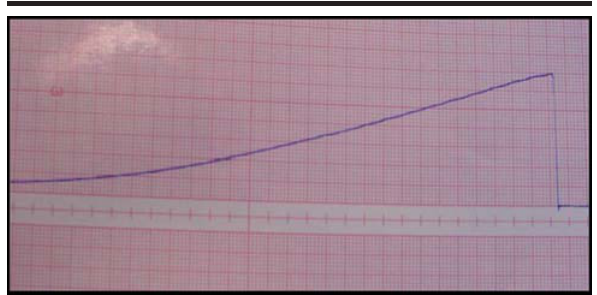
FIGURE 7 - Graphic recording showing the Pressure of Rupture by Distension. The curve is ascending and there is a sudden drop at the rupture time.